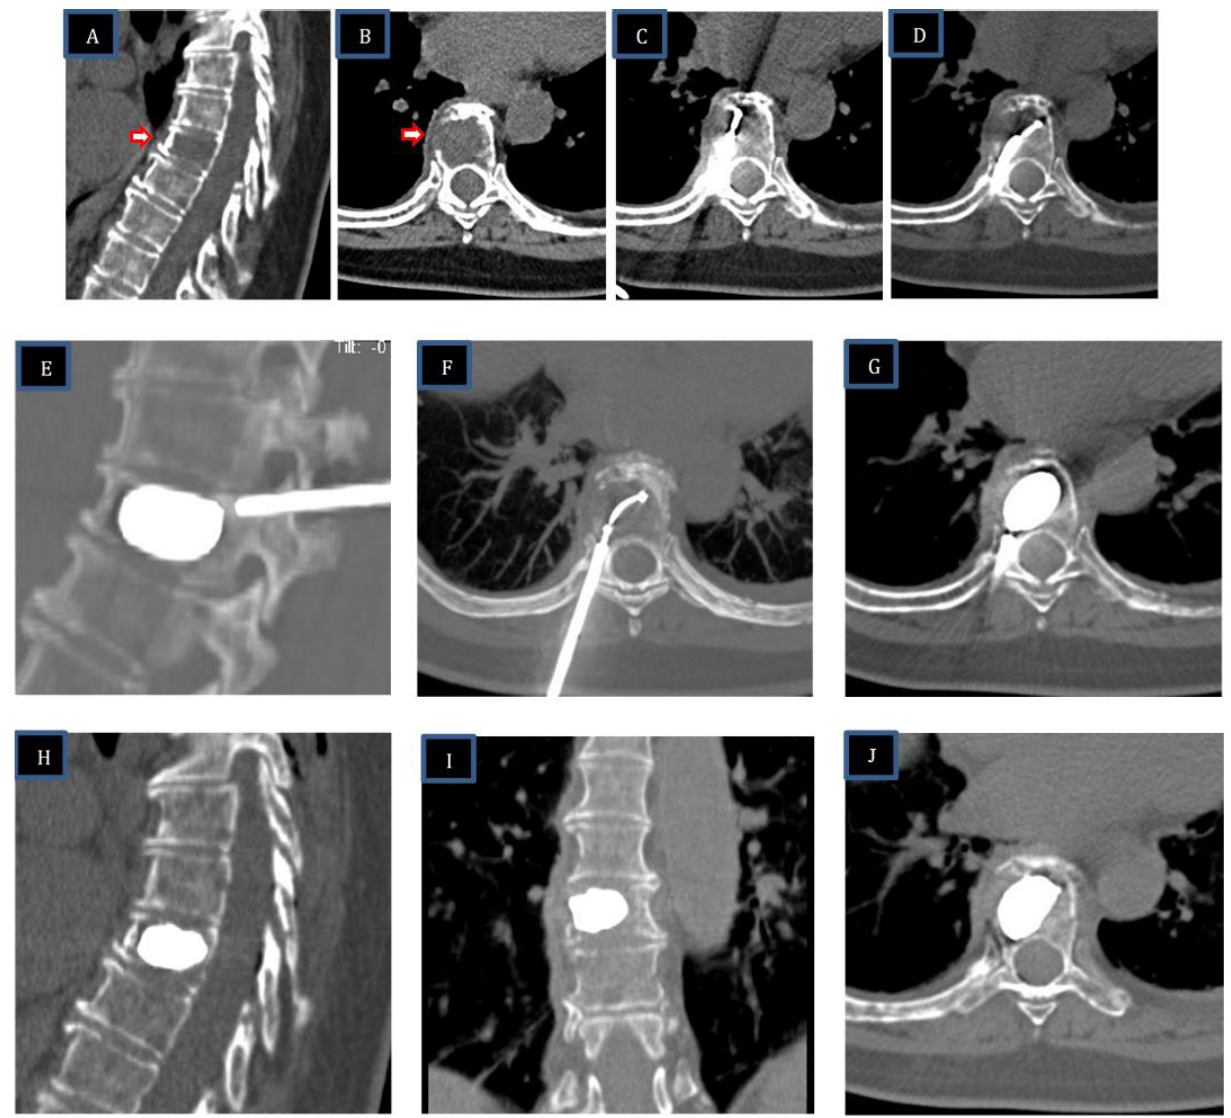
Figure 2. Sixty-year-old female patient with extensive metastatic lytic lesion from breast carcinoma and pathologic fracture of T8. The vertebral body (VB) of T8 has a large interruption of the right lateral wall with initial infiltration of tumor tissue outside VB. ( A , B ): basal CT — sagittal and axial